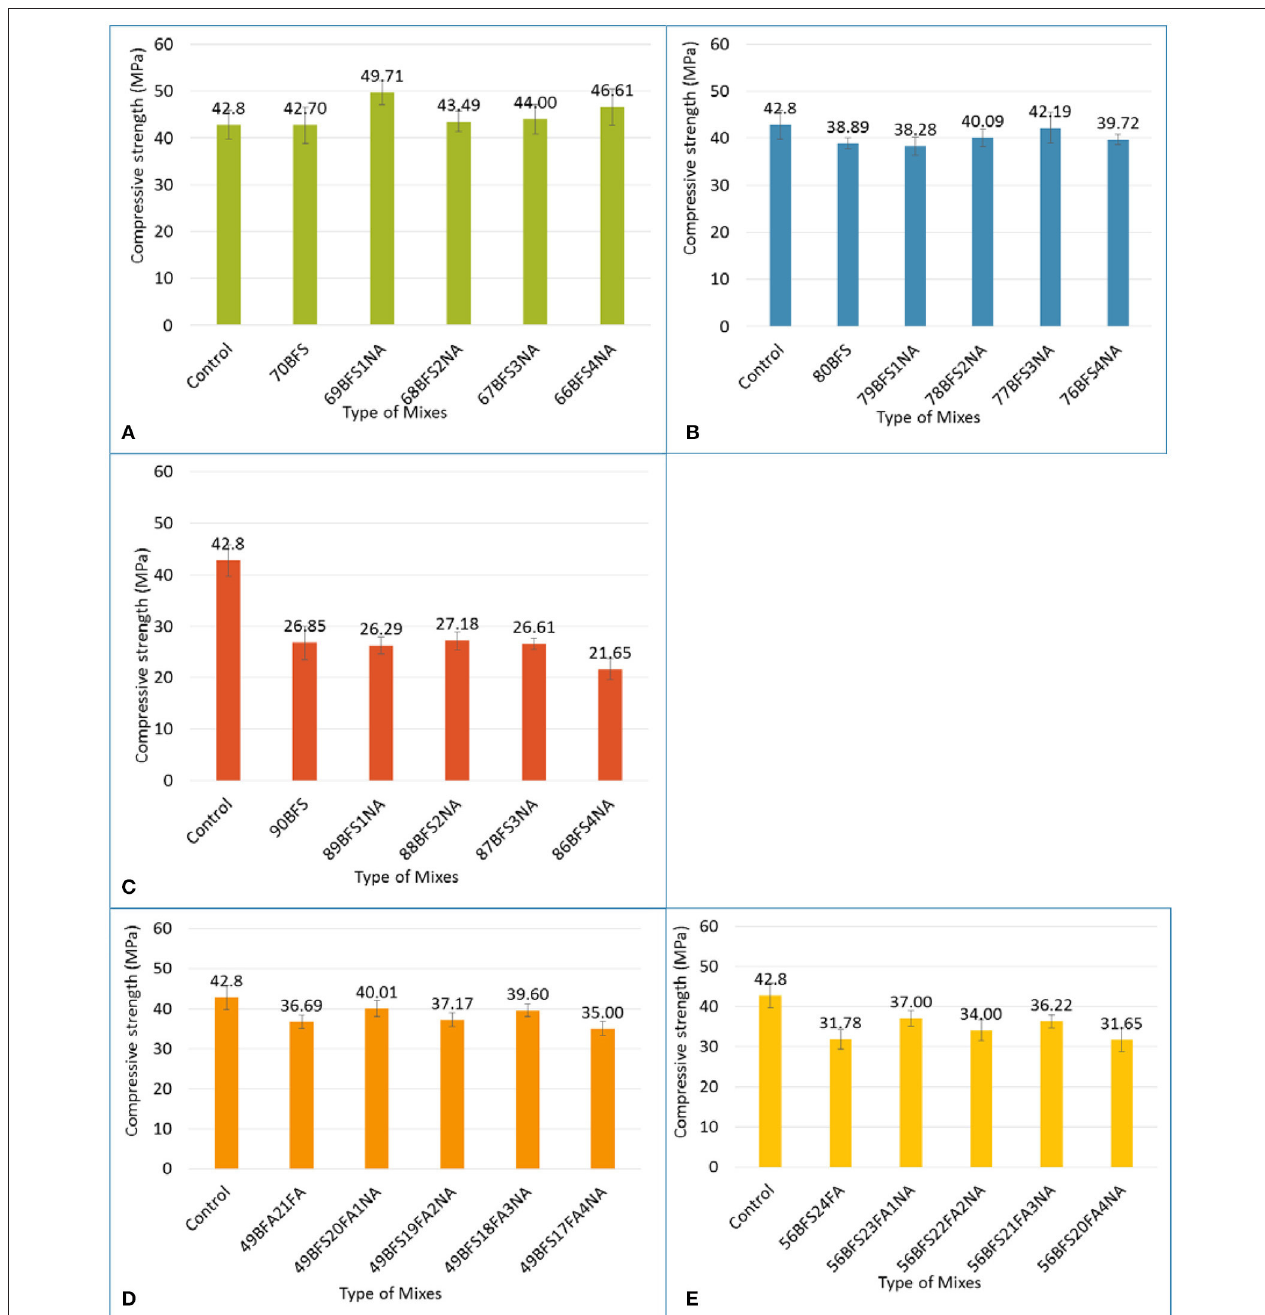
FIGURE 4 | Compressive strength of cement pastes containing (A) 70% slag, (B) 80% slag, (C) 90% slag, (D) 70% slag-fly ash blend and (E) 80% slag-fly ash blend and those containing various nano alumina contents.